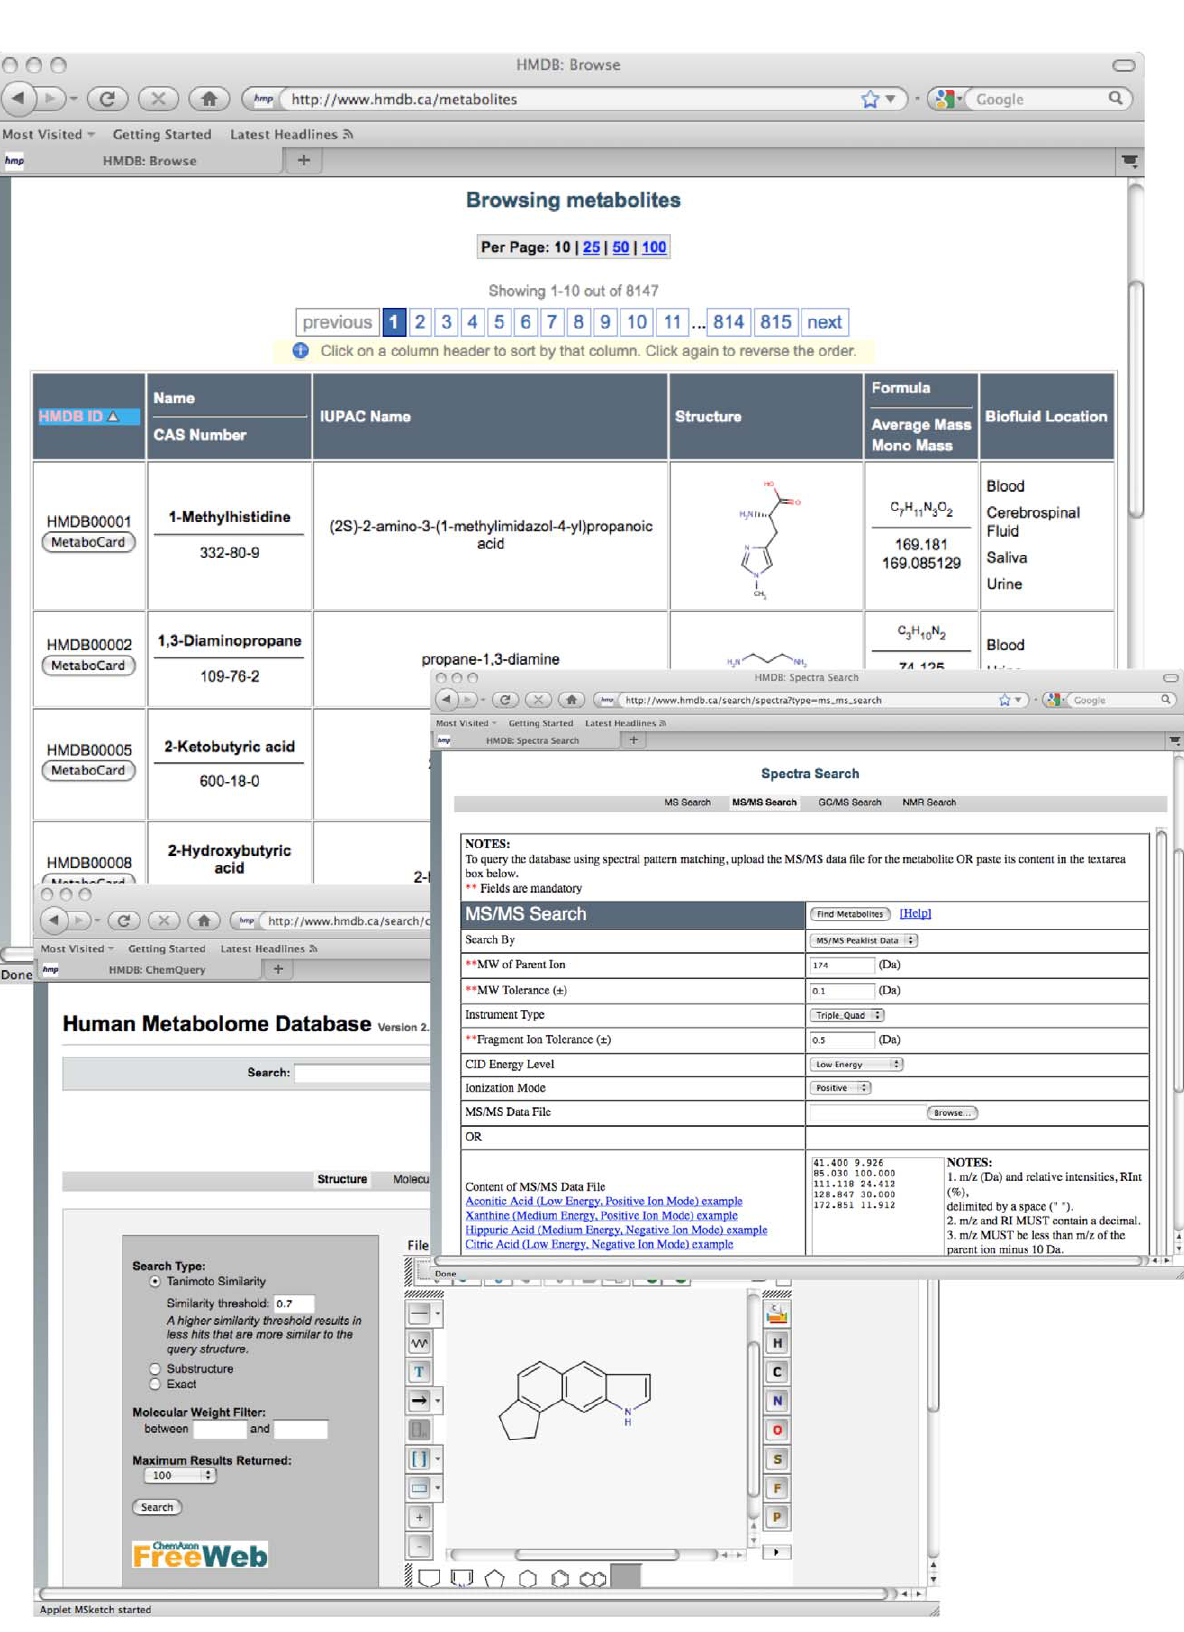
PLOS Computational Biology |